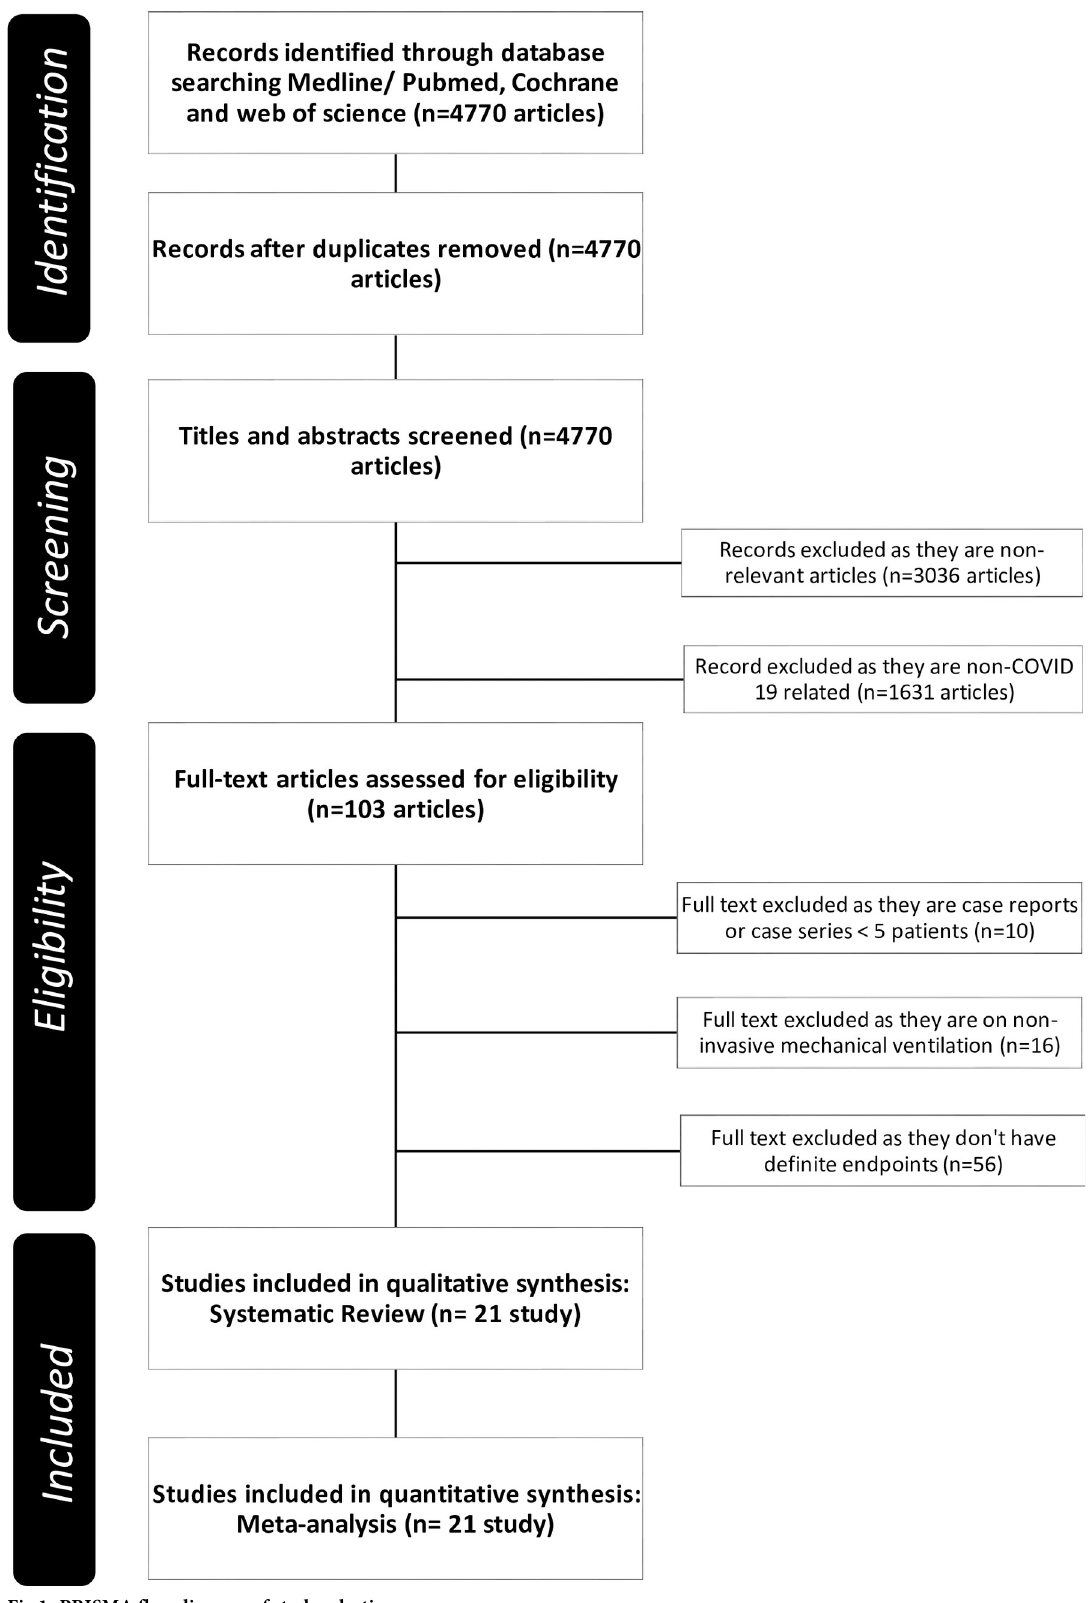
Fig 1. PRISMA flow diagram of study